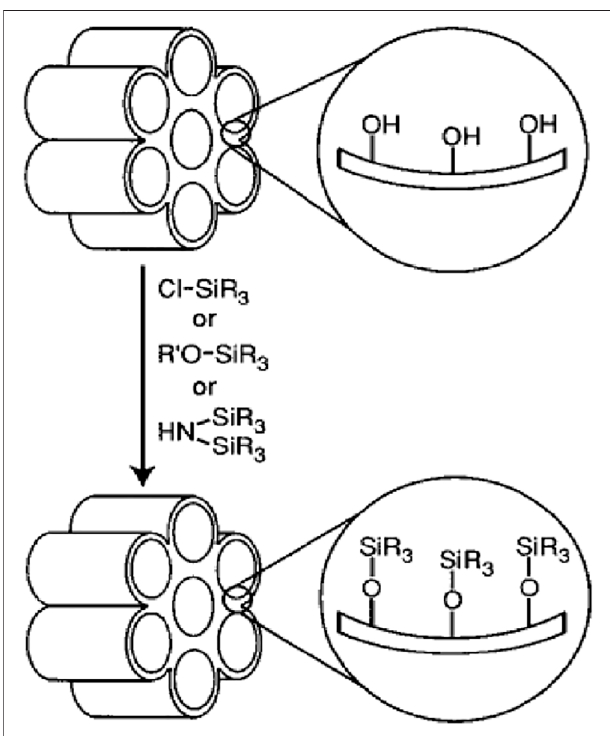
FIGURE 5 | Functionalization of mesoporous silica by